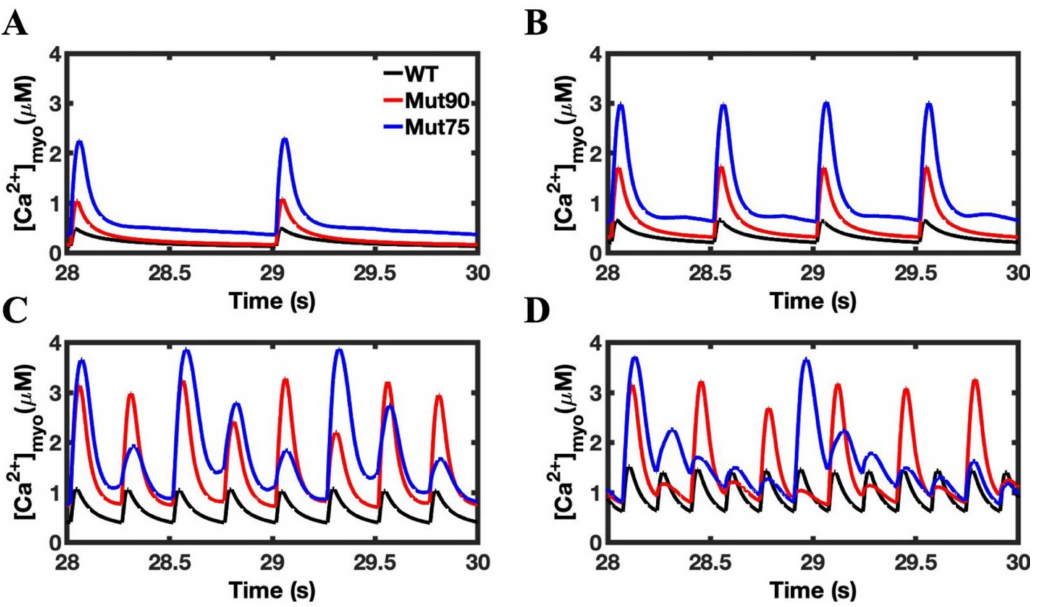
Figure 10. Cellular calcium for beta-adrenergic stimulated cardiac myocytes: ( A ) 1 Hz pacing, ( B ) 2 Hz pacing, ( C ) 4 Hz pacing, ( D ) 6 Hz pacing. The mutant simulations CDI (75% of transition rate—blue and 90% of transition rate—red) of the cardiac myocyte show that the impacts on cellular calcium concentration of mutant cardiac myocytes is exaggerated under beta-adrenergic stimulation compared to wild type (black). Shown are representative simulations out of six repeated simulations with different random number seed values in each case. The different simulation traces for each condition overlap at steady-state pacing.